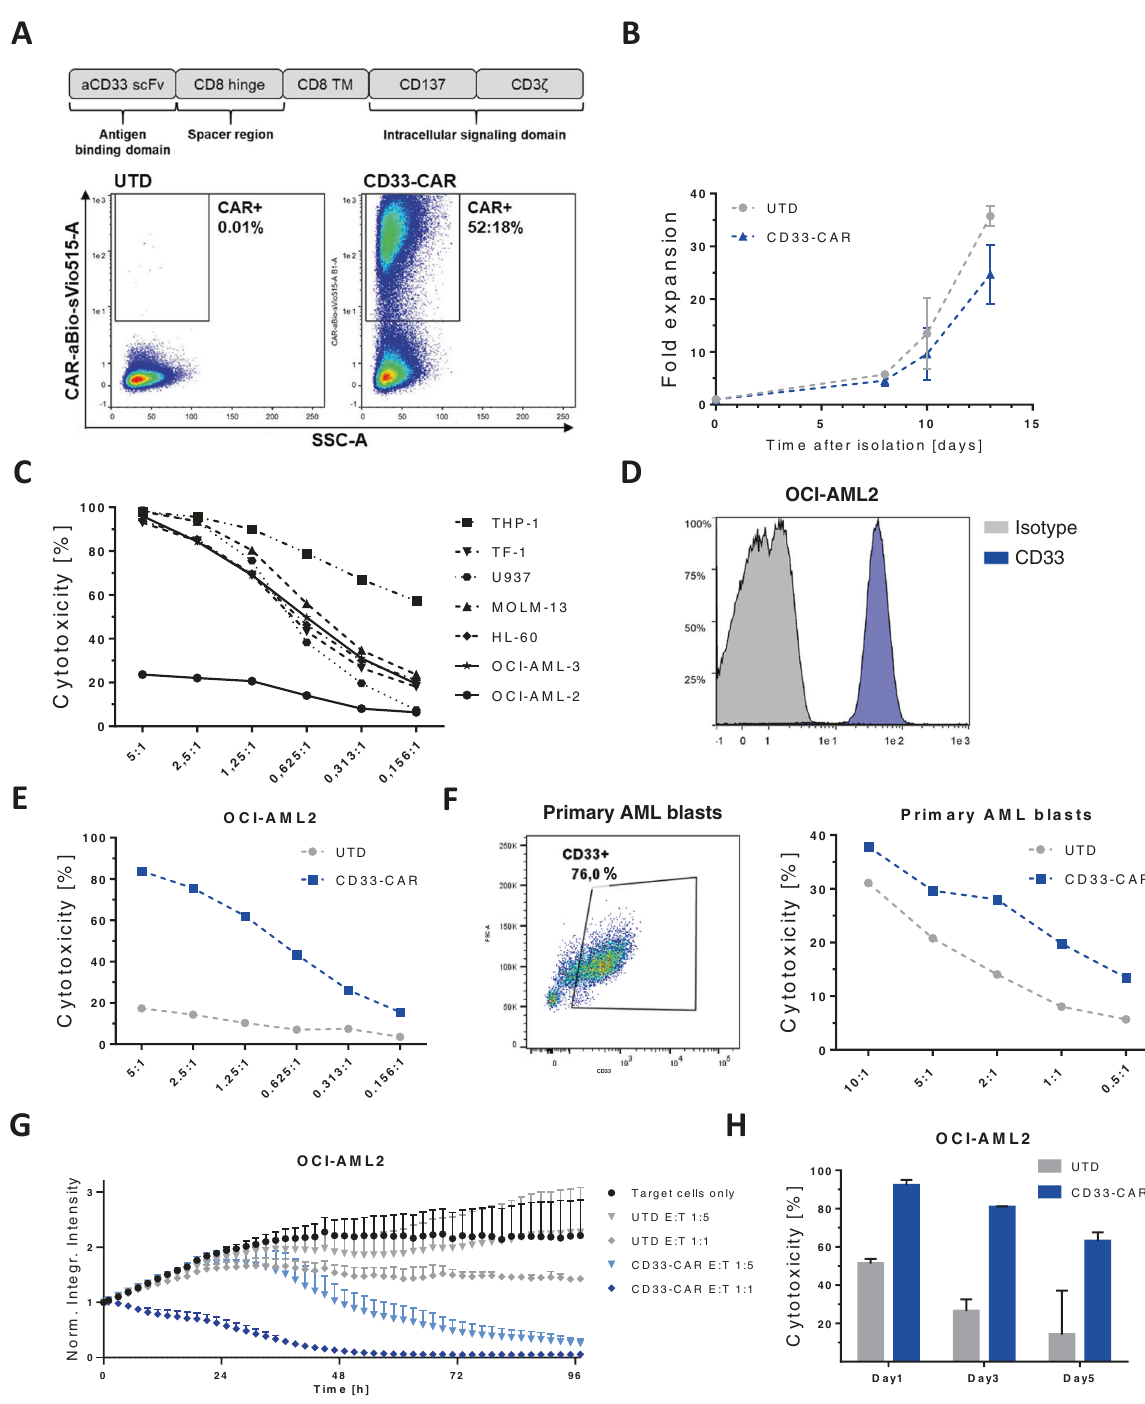
Fig. 1 CD33-CAR-NK cells display robust in vitro effector function against CD33-positive AML cells that are partially resistant to natural cytotoxicity. A Schematic representation and surface expression of the CD33-directed second-generation CAR used in this study. Expression was analyzed by fl ow cytometry 12 days after transgene transfer into primary NK cells. B Time-lapsed expansion of CAR-transduced (CD33-CAR) and untransduced (UTD)-NK cells in the presence of IL-2 (500 IU/mL) and IL-15 (140 IU/mL) ( n = 5). C Expanded NK cells show high cytotoxic activity against various AML cell lines except OCI-AML2. On day 14 of expansion, NK cells were co-incubated with various AML target cells at indicated E:T- ratios. After 24h, the fraction of viable target cells was quanti fi ed by fl ow cytometry. Data shown are representative of results from two independent experiments. D The AML cell line OCI-AML2 displays high CD33 surface expression. E , F NK cells equipped with a CD33-CAR become highly cytotoxic against OCI-AML2 and CD33-positive primary AML cells. Cells were co-cultivated for 4 h and the viability of target cells was quantitated by fl ow cytometry. Two representative experiments are shown. G Dynamic monitoring of CAR-NK cell-mediated cytotoxicity. On day 12 after transduction, CAR-NK cells were co-cultured with (GFP + ) OCI-AML2 cells and fl uorescence emission was measured in the IncuCyte S3 imaging platform over 4 days. Shown is one representative from three separate experiments with a total of 5 donors. H Repetitive tumor-challenge assay revealed superior serial killing capacity of CD33-CAR-NK cells compared to UTD-NK cells. Expanded NK cells at day 12 post transduction were co- cultured with OCI-AML2 cells at an E:T-ratio of 1:1 and re-challenged with AML cells every other day. Shown is one representative experiment with a total of two donors. All graphs show mean of replicated ±